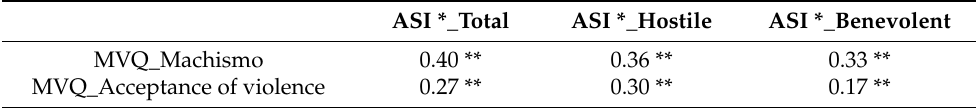
Table 4. Correlation matrix examining the convergent validity.